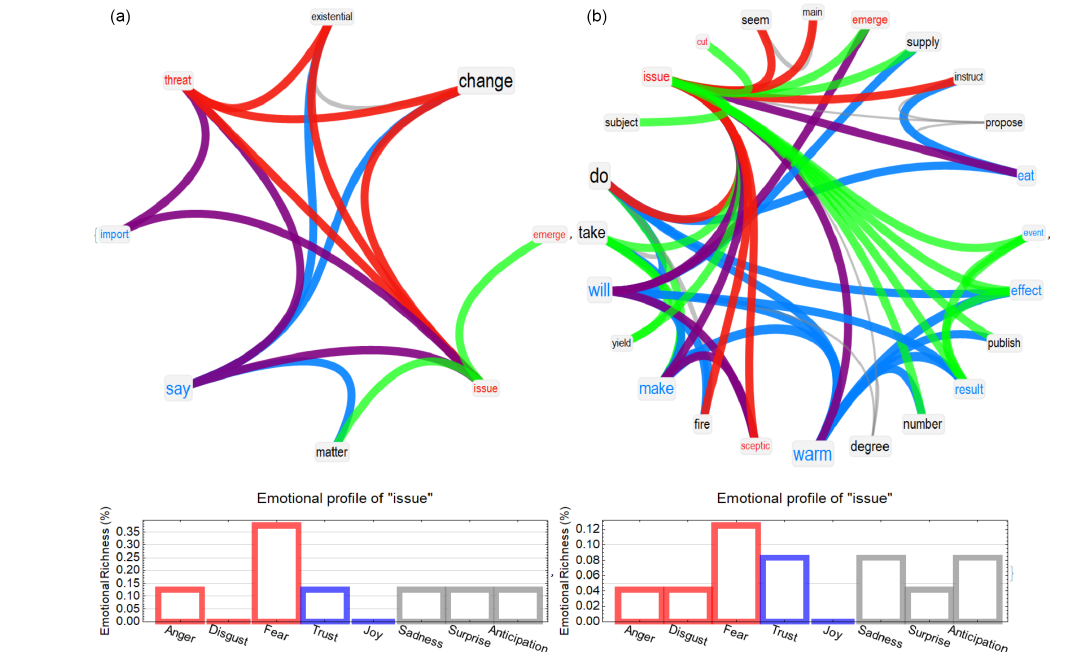
Figure A4. Speakers’ mindset reconstruction around “issue” in the speeches of Greta Thunberg (a) and Christopher Monckton (b) . We refer the reader to Fig. 1 for a detailed explanation of the colour code and to Lexicon 1 for an interpretation of the figure.